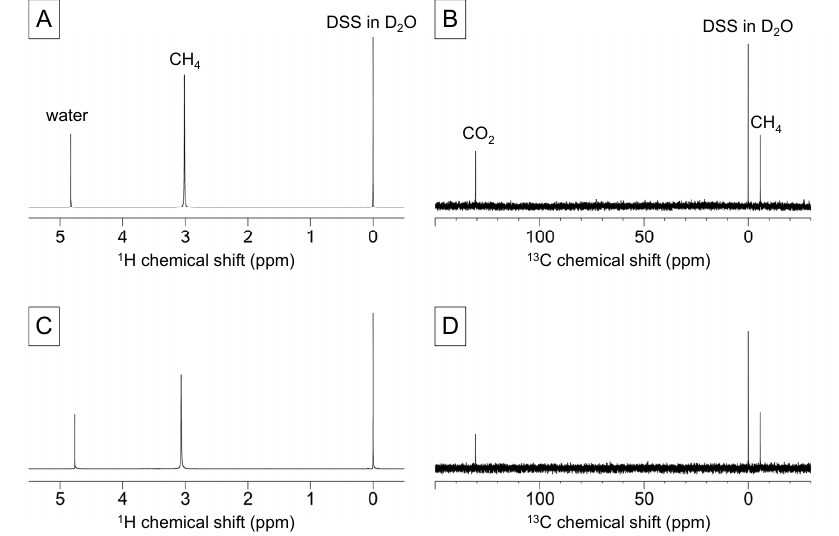
Figure 5. Summary of the thermophilic microbial degradation of BC. The reactions are divided into 3 stages as follows: hydrolysis, acidification, and CH